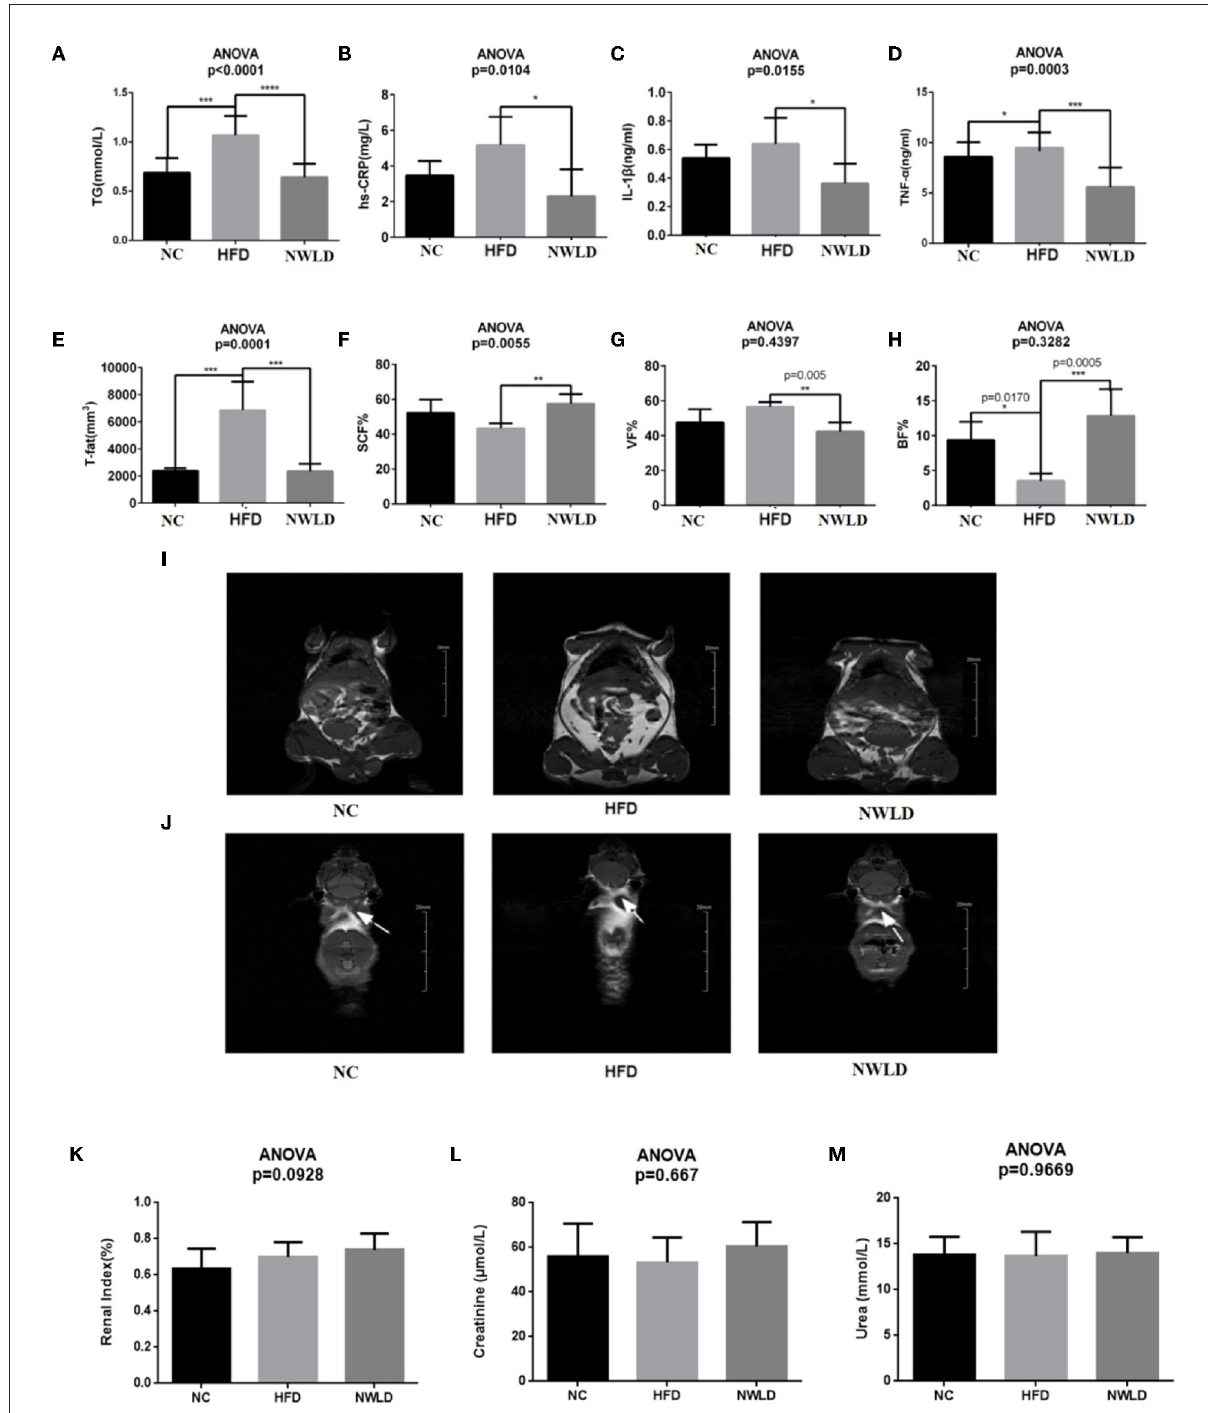
FIGURE1 Comparison of phenotypic factors among groups. Bar charts of (A) serum triglycerides (TG), (B) hs-CRP, (C) IL-1 β , (D) TNF- α , (E) total fat, (F) subcutaneous fat percentages, (G) visceral fat percentages, (H) brown fat percentages, and (I) white fat (the highlighted areas in the abdomen and subcutaneous tissue) in each group (coronal plane). Images were taken from NC4 section 7, HFD3 section 9, and NWLD3 section 6. (J) Brown fat of mice in different groups (butterfly areas are indicated by arrows). Images were taken from NC2 section 8, HFD5 section 29, and NWLD4 section 29. * p < 0.05; ** p < 0.01; *** p < 0.001; **** p < 0.0001. Bar charts of (K) renal index, (L) serum creatinine, (M) serum